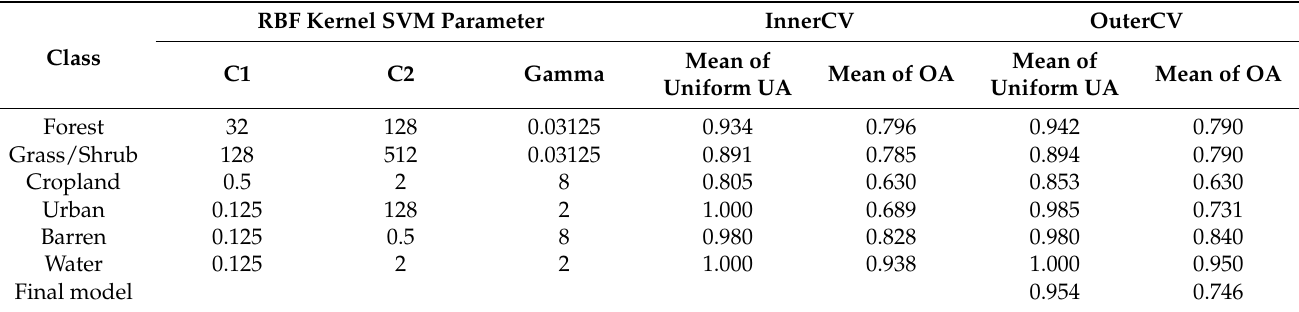
Table 6. Results of adjusting SVM hyperparameters and model accuracy.